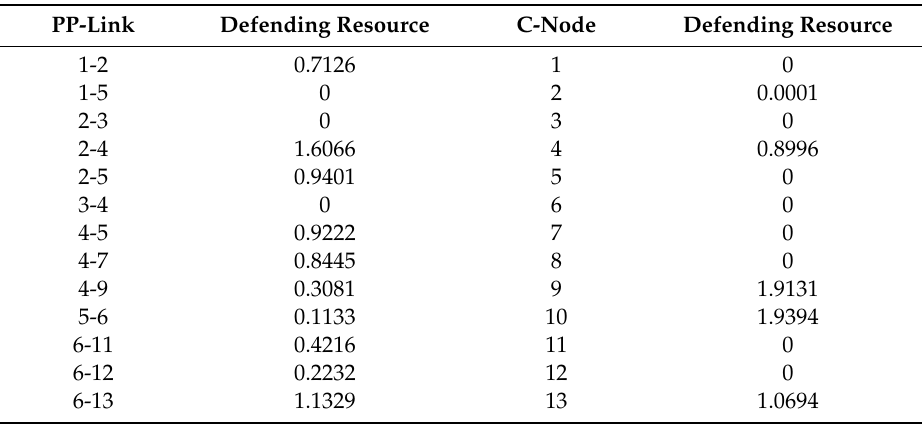
Table 2. Distributions of defending resources in Case